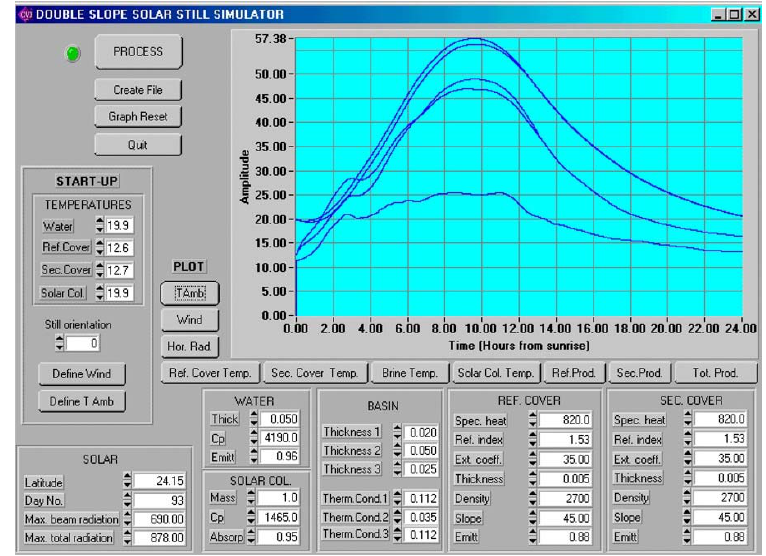
Figure 7. Computer simulator of the thermal performance of a double ‐ slope condensing cover solar still.